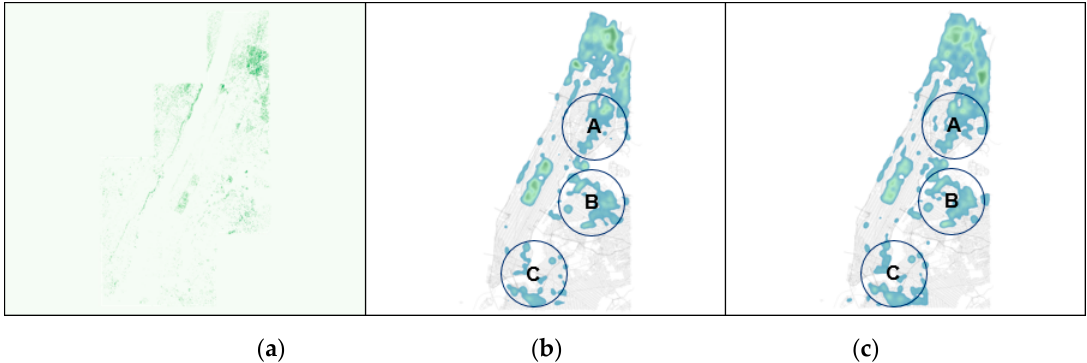
Figure 5. Comparison of significant areas in New York. ( a ) NDVI analysis result; ( b ) UGA heat map with choice 1600 m setting; ( c ) UGA heat map with integration 1600 m setting.